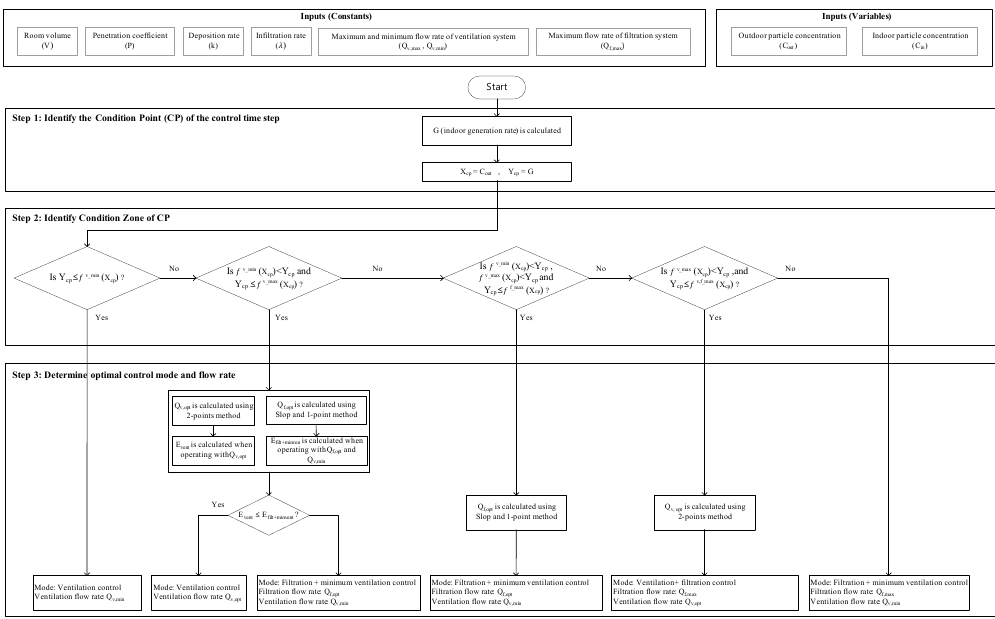
Figure 10. Optimization control process of the ventilation and filtration system.